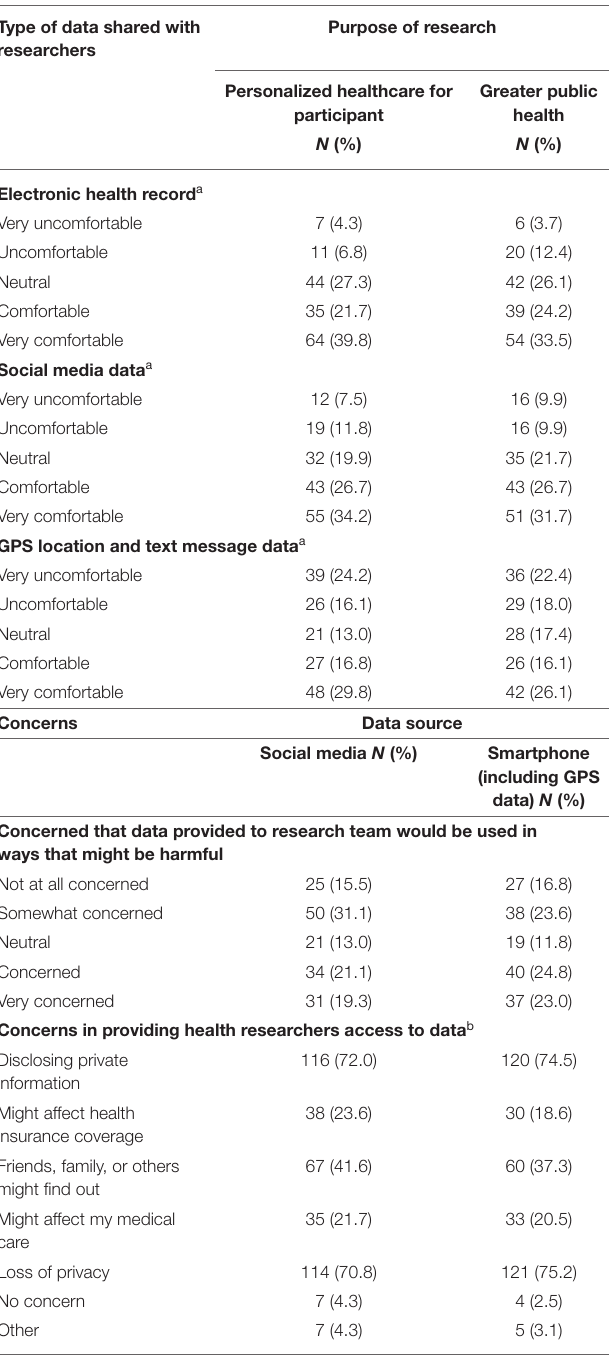
TABLE 2 | Participant concerns and comfort level sharing data with